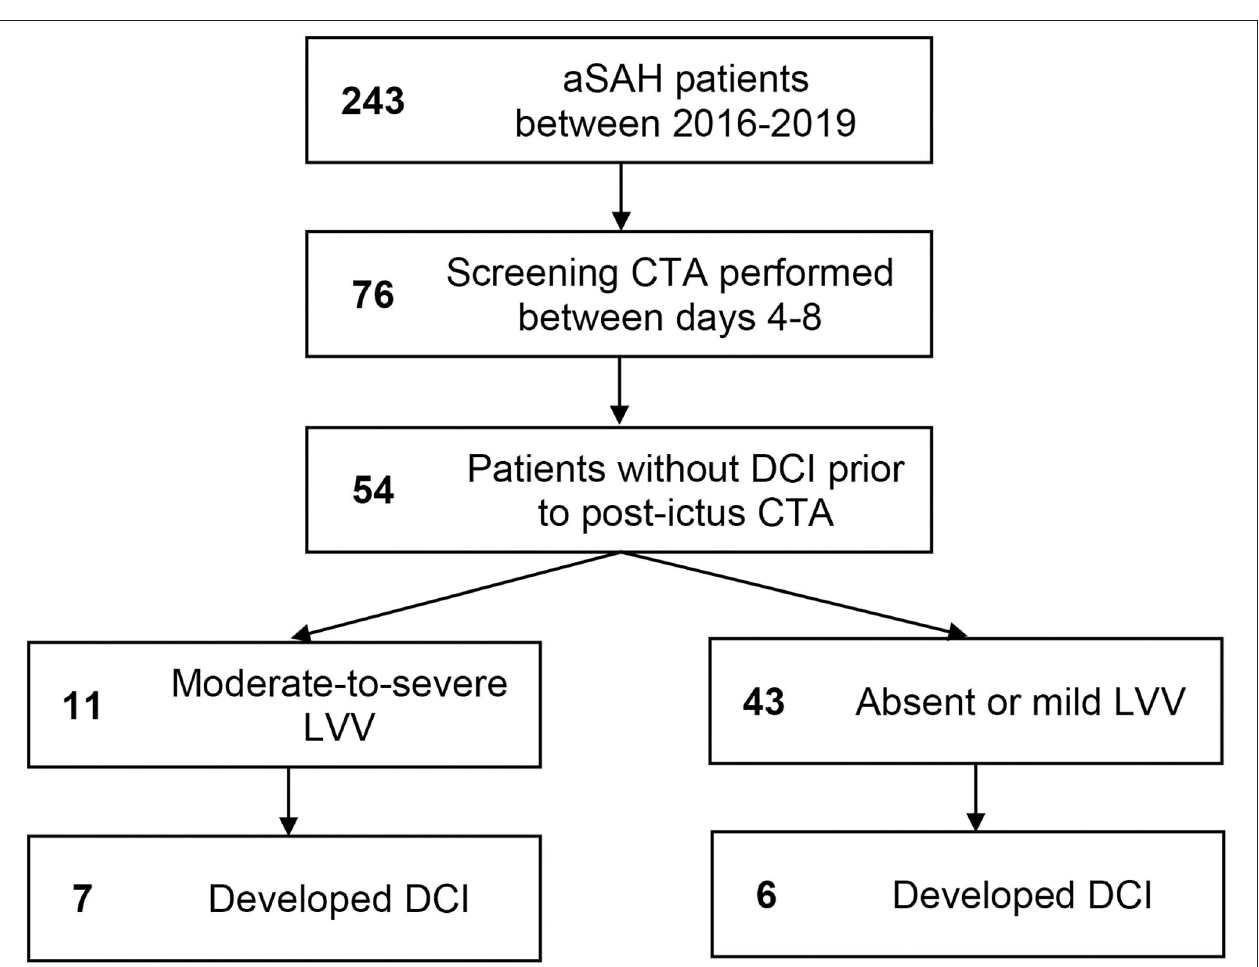
FIGURE 1 | Flowchart of patients enrolled in the study. vasospasm, these are slightly lower, with a sensitivity and specificity of 82–90% and 50–69%, respectively (16). Our study suggests that an optimal multimodal approach may combine